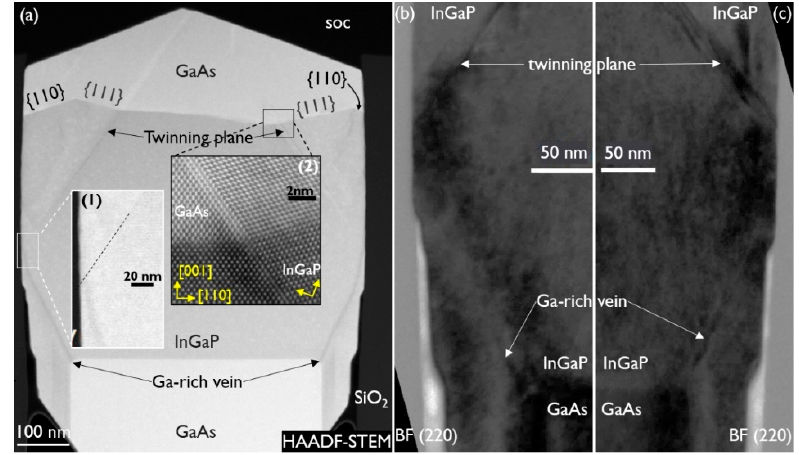
Figure 7. ( a ) Cross-section HAADF-STEM image of a GaAs/InGaP/GaAs NR grown at 590 °C. Inset (1): magnification of site of origin of the twinning plane (indicated by the dashed line). Inset (2): high-resolution image of the GaAs/InGaP interface across the twinning plane. Magnification in BF (220) conditions of left ( b ) and right ( c ) side of the NR shown in Figure ( a ) where the twinning plane originates in the InGaP layer at the oxide wall.